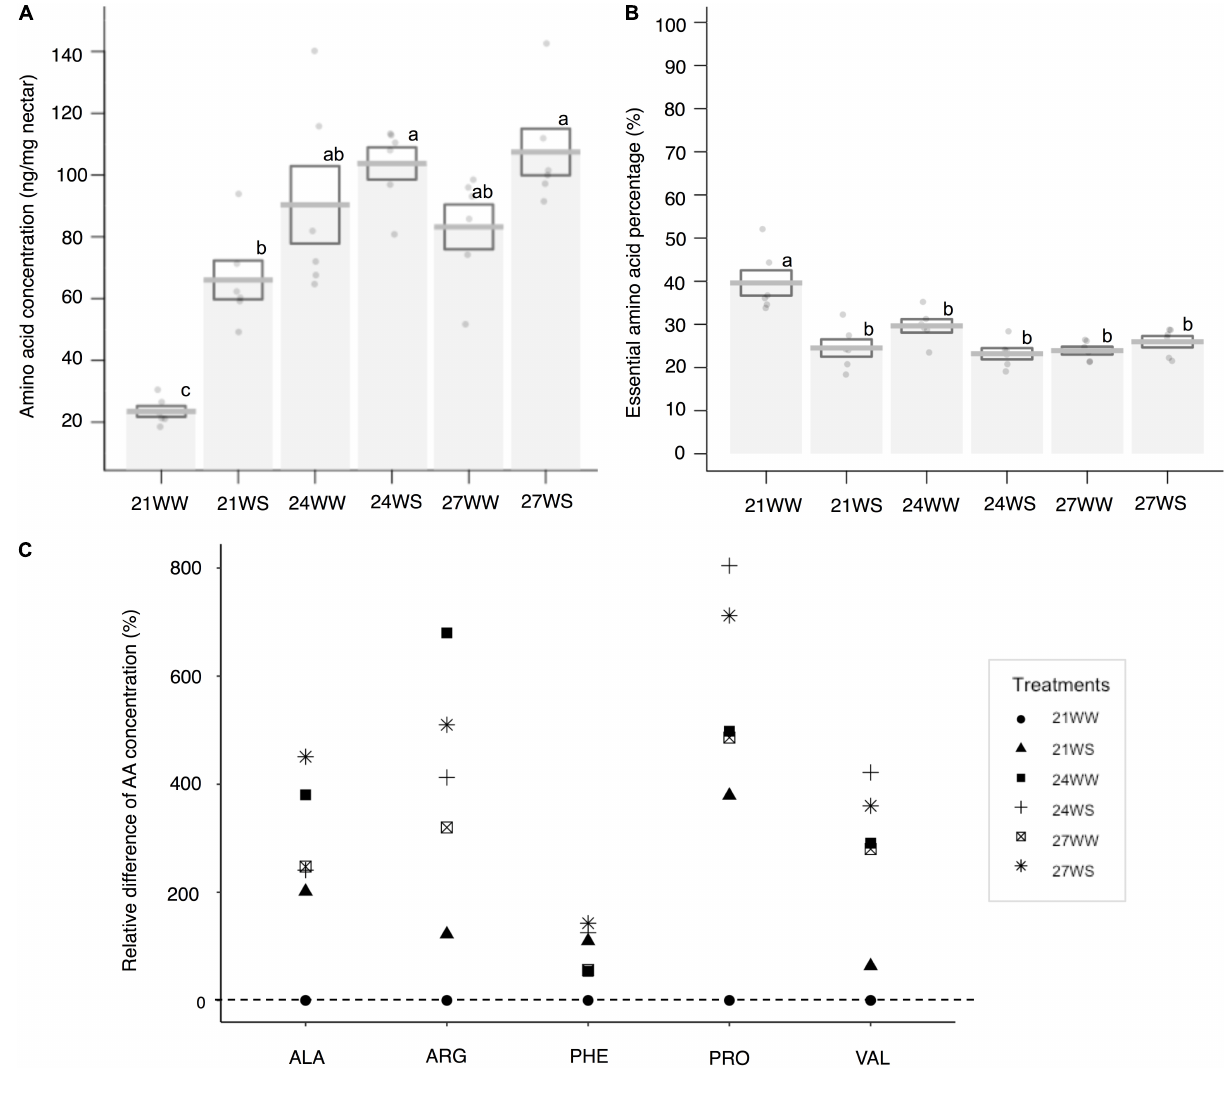
FIGURE 3 | Effects of temperature rise and water stress on nectar amino acid content of B . officinalis , 3 weeks after stress induction: (A) total nectar amino acid concentration (ng/mg nectar); (B) essential amino acid percentage compared to total concentration (%); (C) relative difference in amino acid concentration (%). N = 3 plants (replicates). (A,B) Data are mean ± SE; data points followed by different letters for the same parameter are significantly different at P < 0.05 among treatments; (C) data are mean and relative values compared with 21WW. 21, 21 ◦ C; 24, 24 ◦ C; and 27, 27 ◦ C; WW, well-watered; WS, water-stressed. Only significant changes in amino acid concentrations are shown: ALA, alanine; ARG, arginine; PHE, phenylalanine; VAL, valine; PRO,